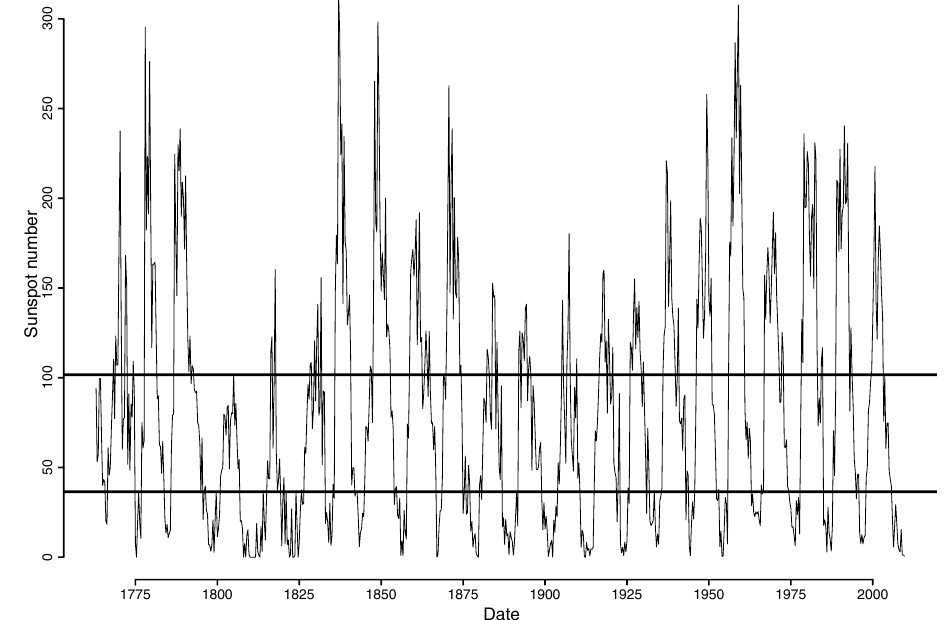
Figure 1. 1763–2009 JFM monthly sunspot number with 33rd and 66th percentile thresholds.